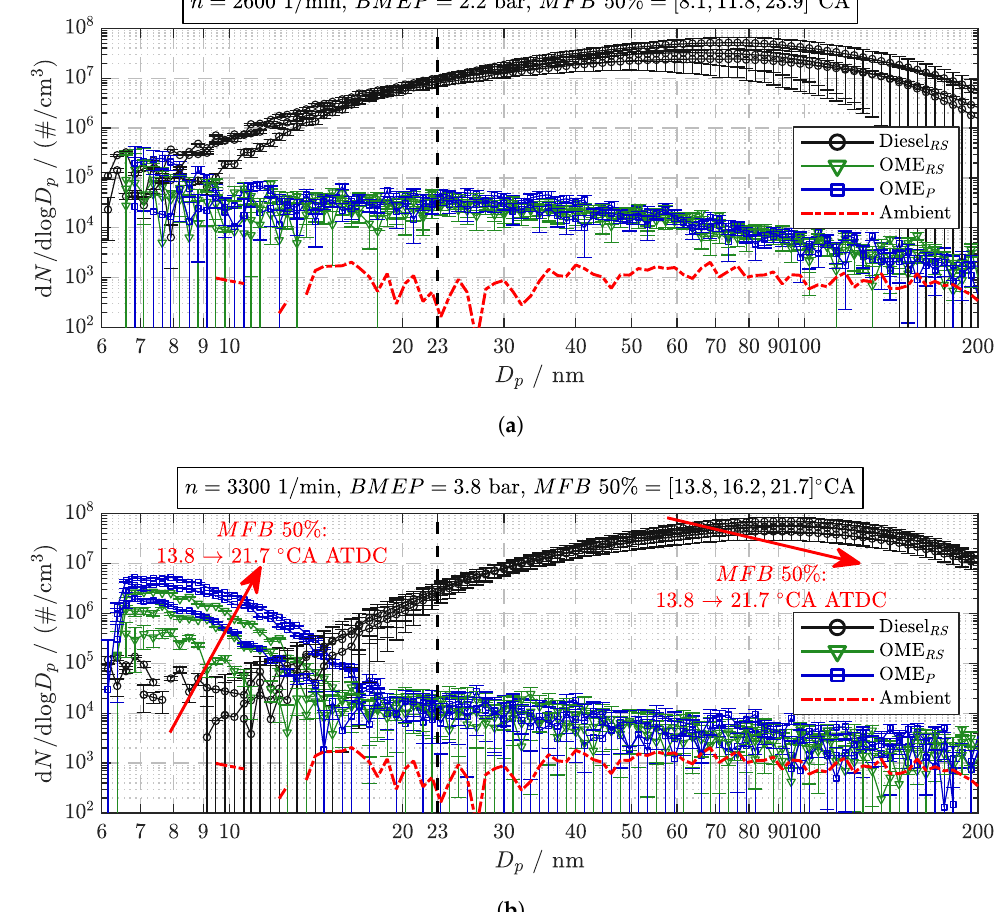
Figure 9. Particle size distribution for three different MFB 50% at OP 1 ( a ) and OP 2 ( b ) for diesel and two different nozzles in OME operation. Hint: Size distribution for MFB 50% = 8.1 ◦ CA ATDC could not be measured for P-nozzle in ( a